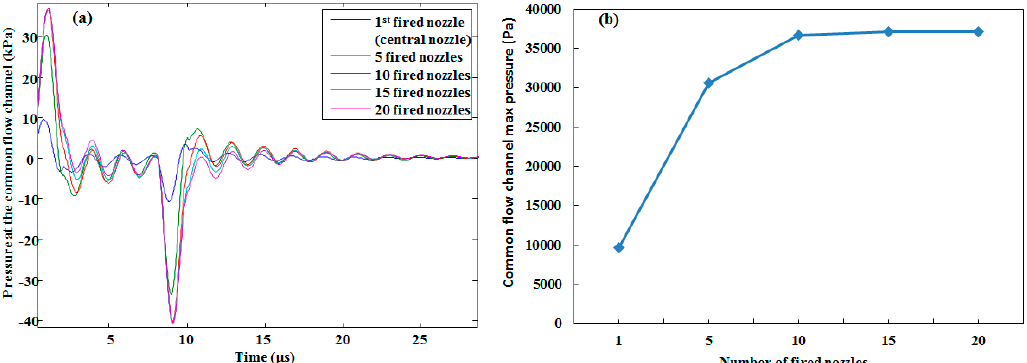
Figure 18. ( a ) Pressure perturbation at the common flow channel of the central activated nozzle when only the central nozzle was fired and with the given numbers of simultaneously fired nozzles. ( b ) Saturation of the pressure perturbation at the common flow channel when the number of fired nozzles was increased.